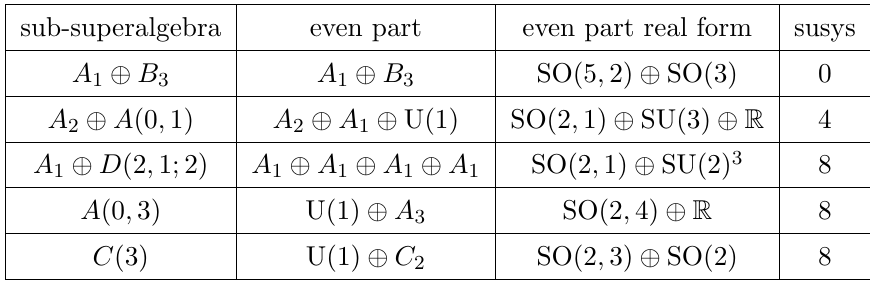
Table 1 . Sub-superalgebras of F